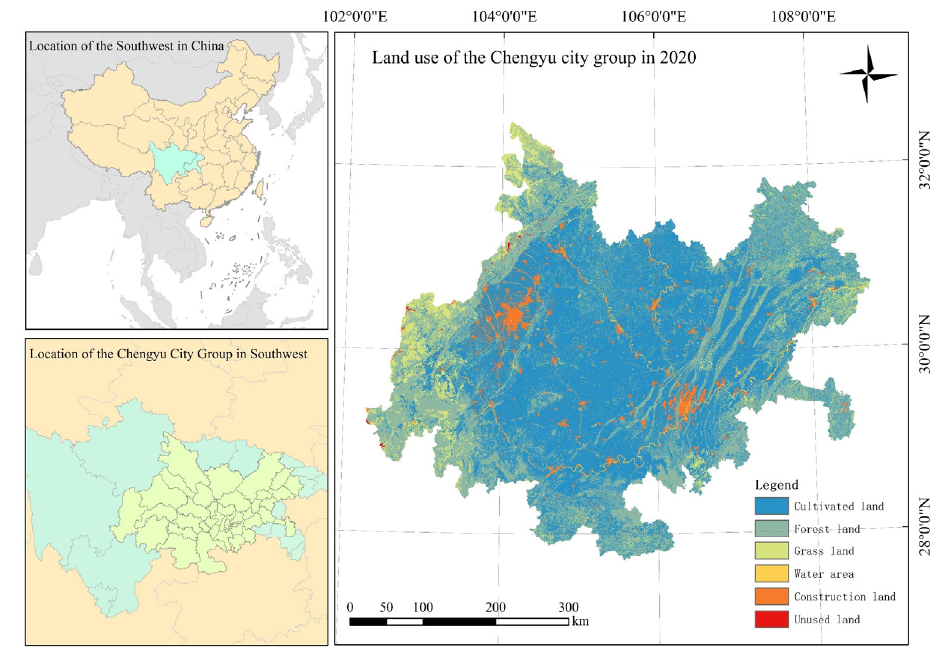
Figure 1. Map of the study area.